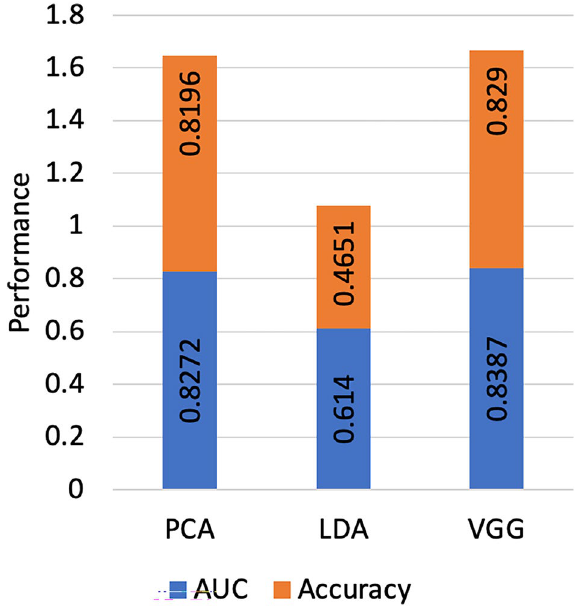
Figure 6. Comparison of the data labeling performance of different feature extraction techniques.